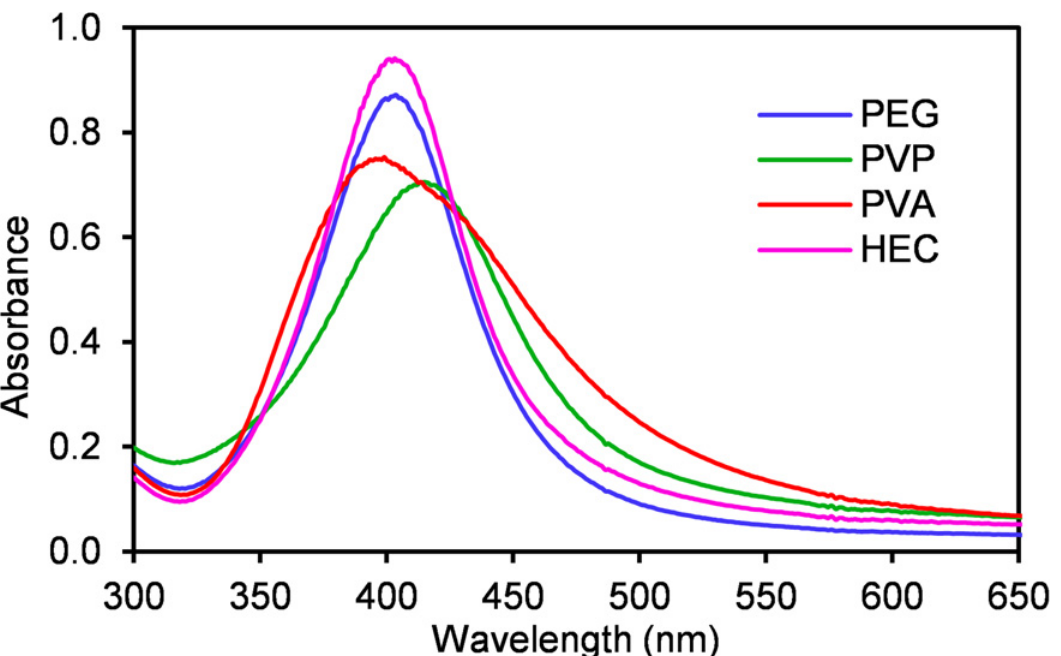
Fig 3. UV-Vis spectra of ten times diluted Ag NPs in aqueous dispersions prepared by the reduction of AgBr NPs by NaBH 4 in the presence of a) PEG, b) PVP, c) PVA and d) HEC.